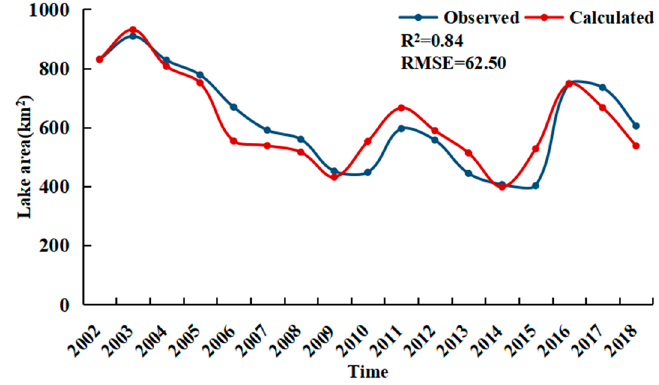
Figure 13. Simulation of lake area based on rainfall and inflow.